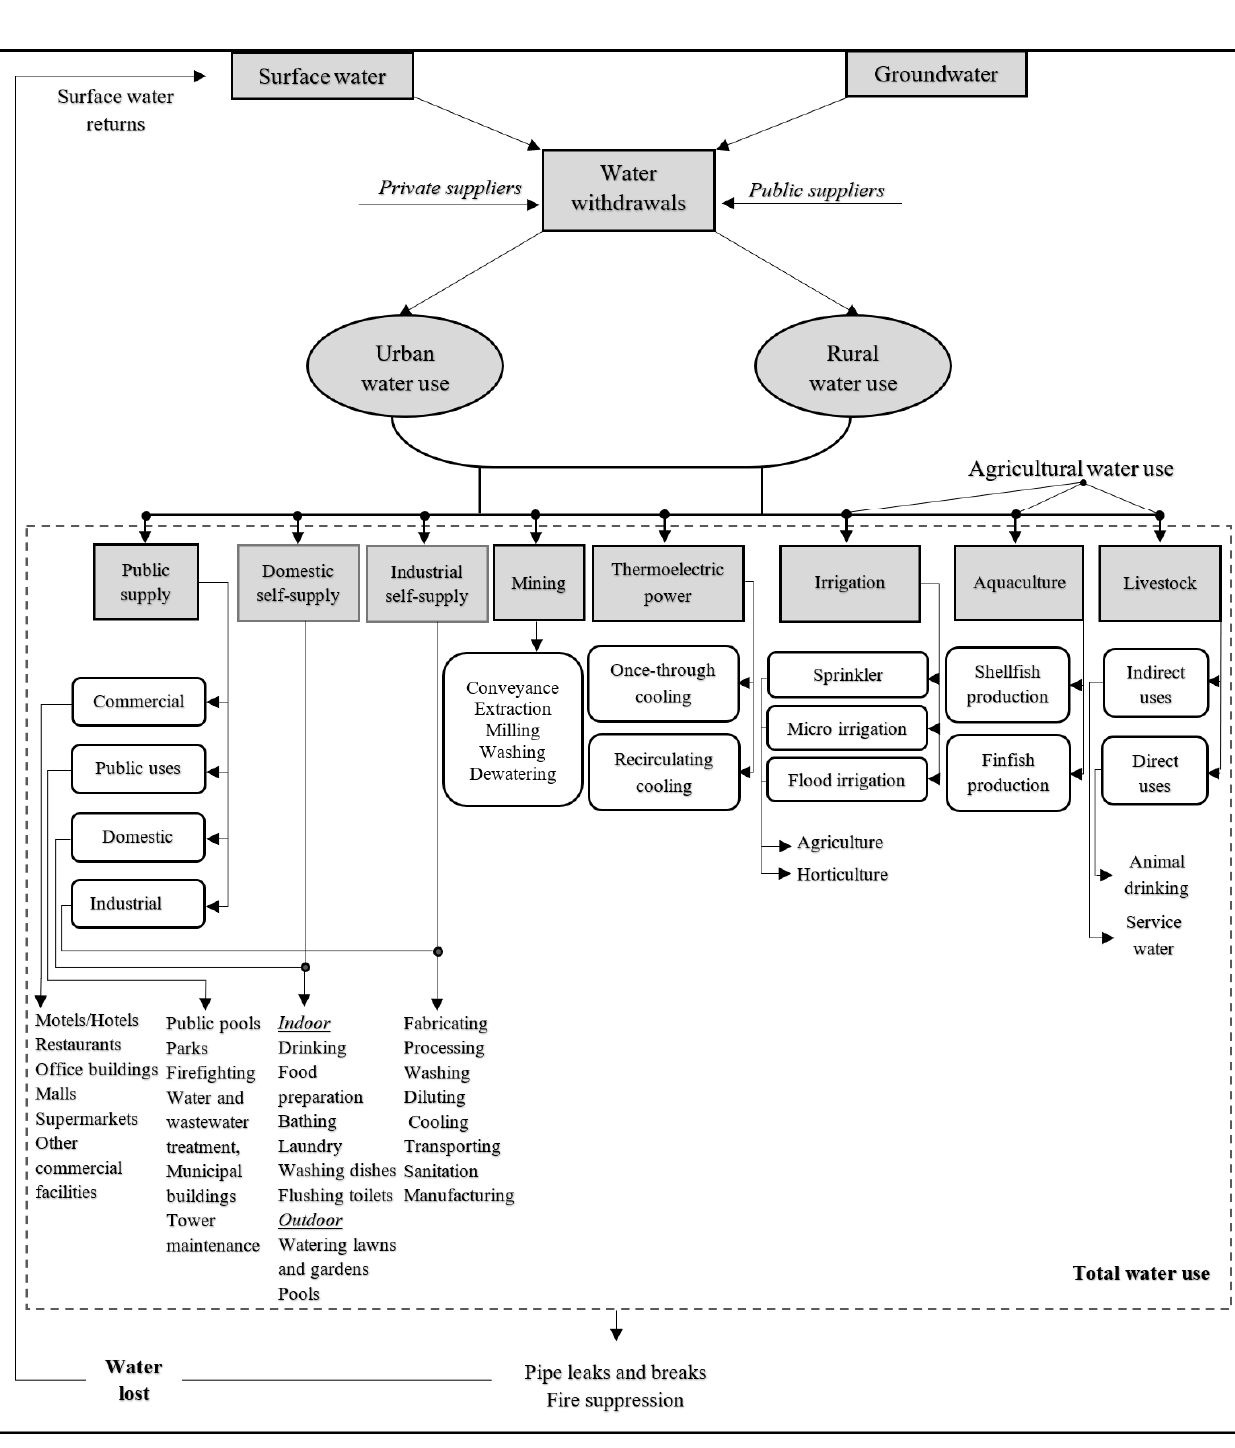
Figure 4. Components of Water Use Indicator used to estimate total water use in Florida.